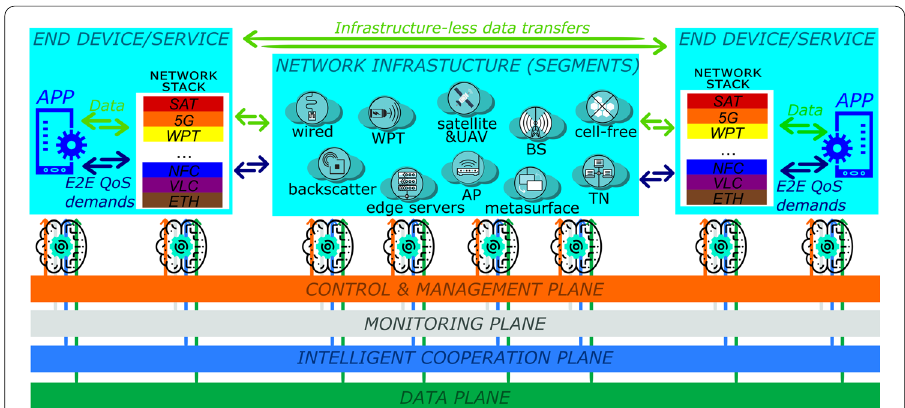
Fig. 2 MTC network architecture. Holistic MTC architecture driven by E2E QoS